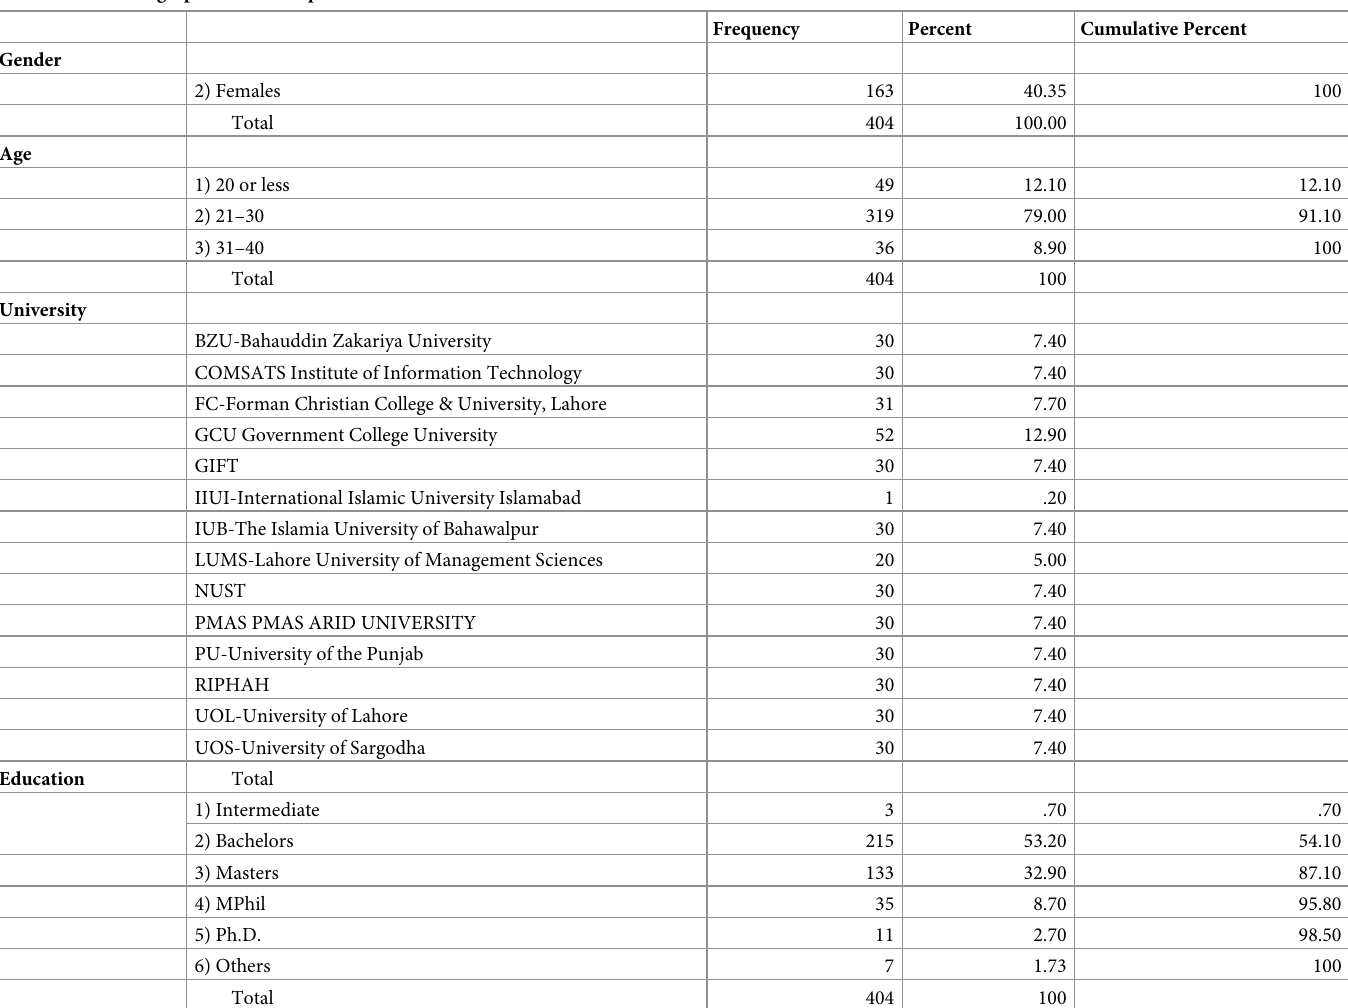
Table 1. The demographics of the